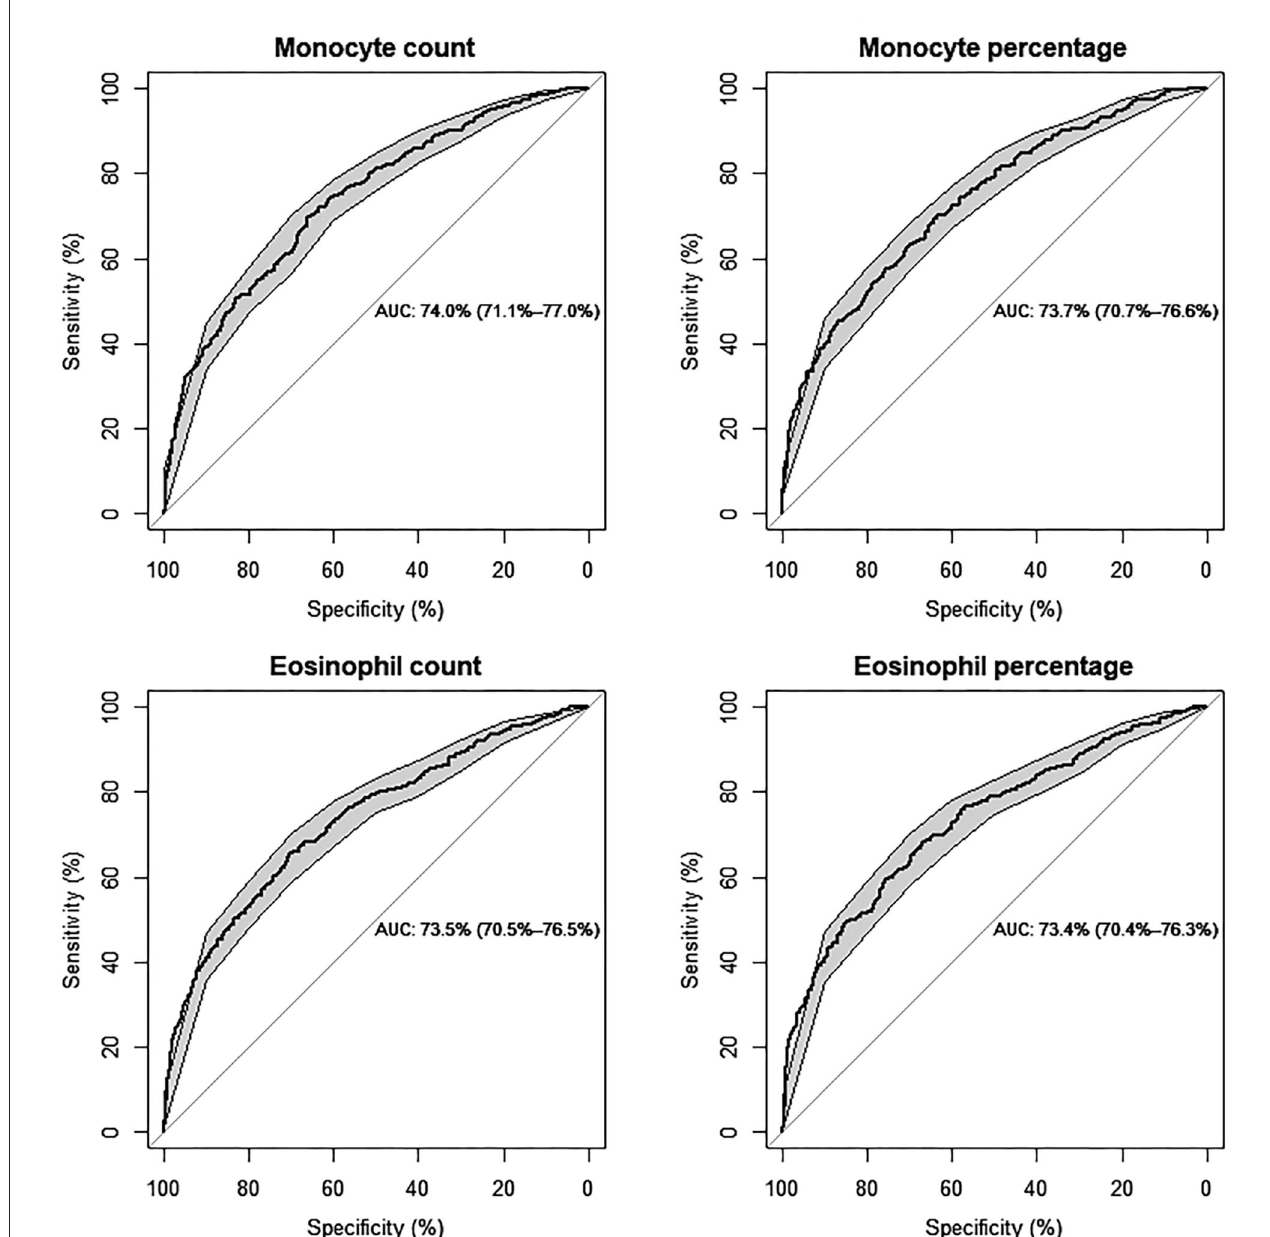
FIGURE 2 | Predictive values of monocyte and eosinophil count (10 9 /L) and percentage (%) for the risk of ISR, respectively, by ROC curve analysis (Models are adjusted for individual basic characteristics, including age, sex, BMI, smoking status, chronic diseases of hypertension and diabetes mellitus, and follow-up time. AUC: area under the curve with 95% confidence